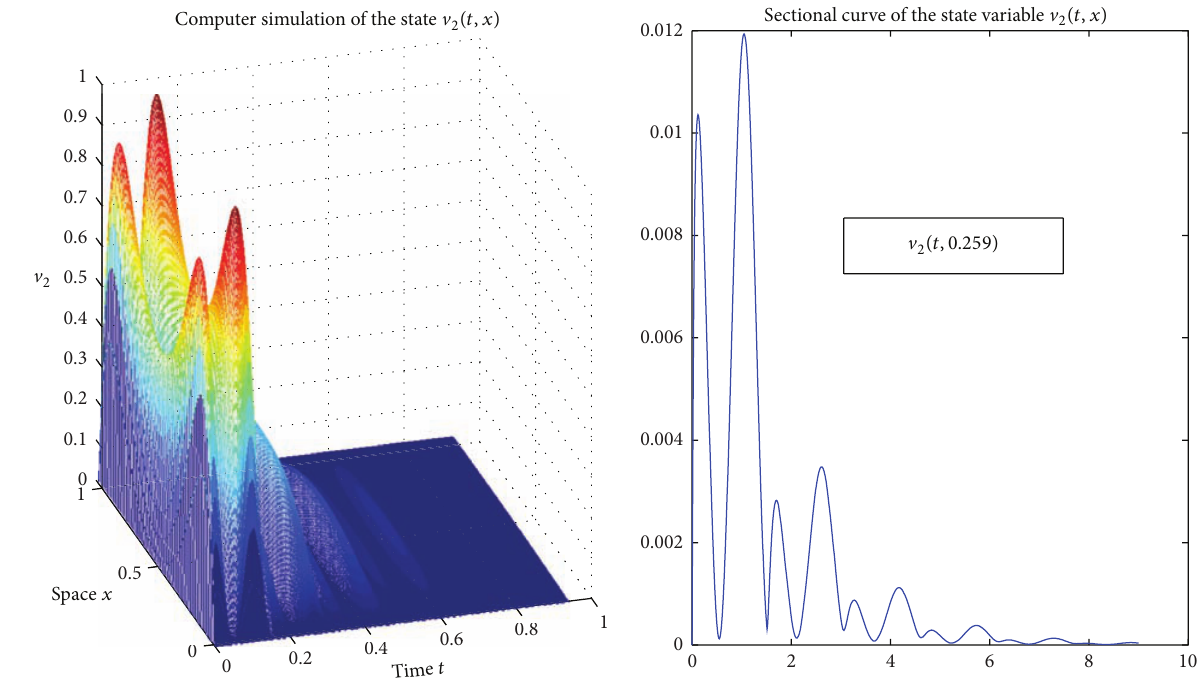
Figure 2: The state variable V 2 (𝑡,𝑥)